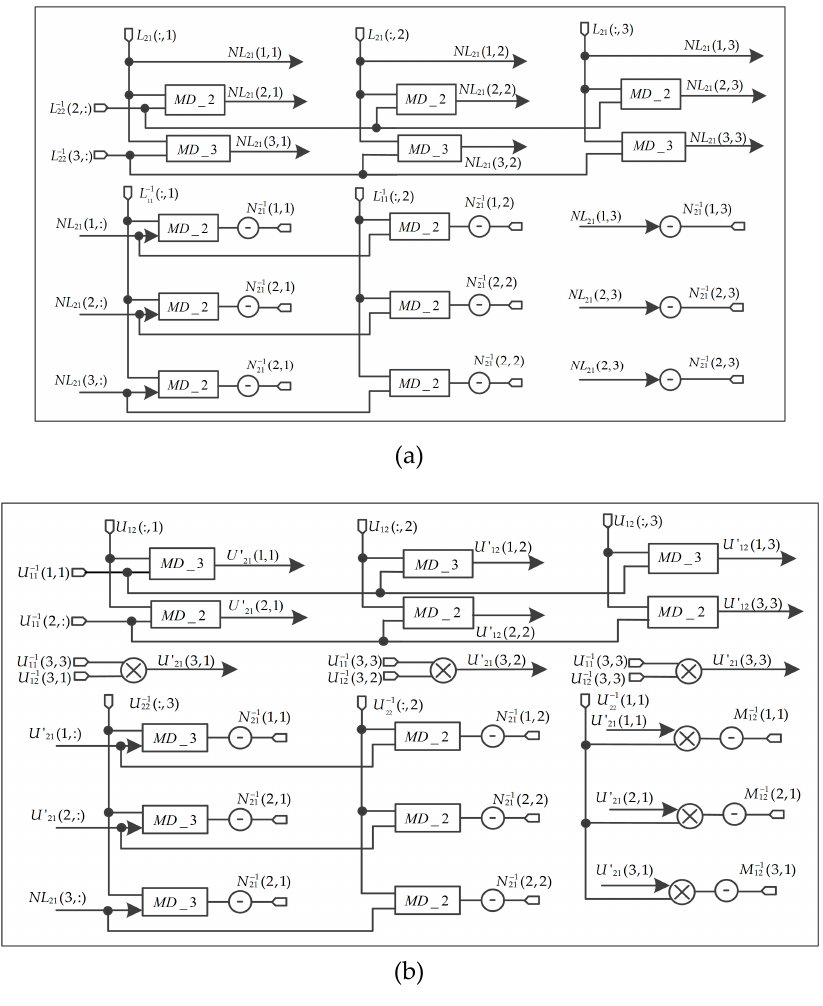
N − and 1 M − ( a ) The architecture of 1 and M − 1 ( a ) The architecture of N − 1 21 12 21 12